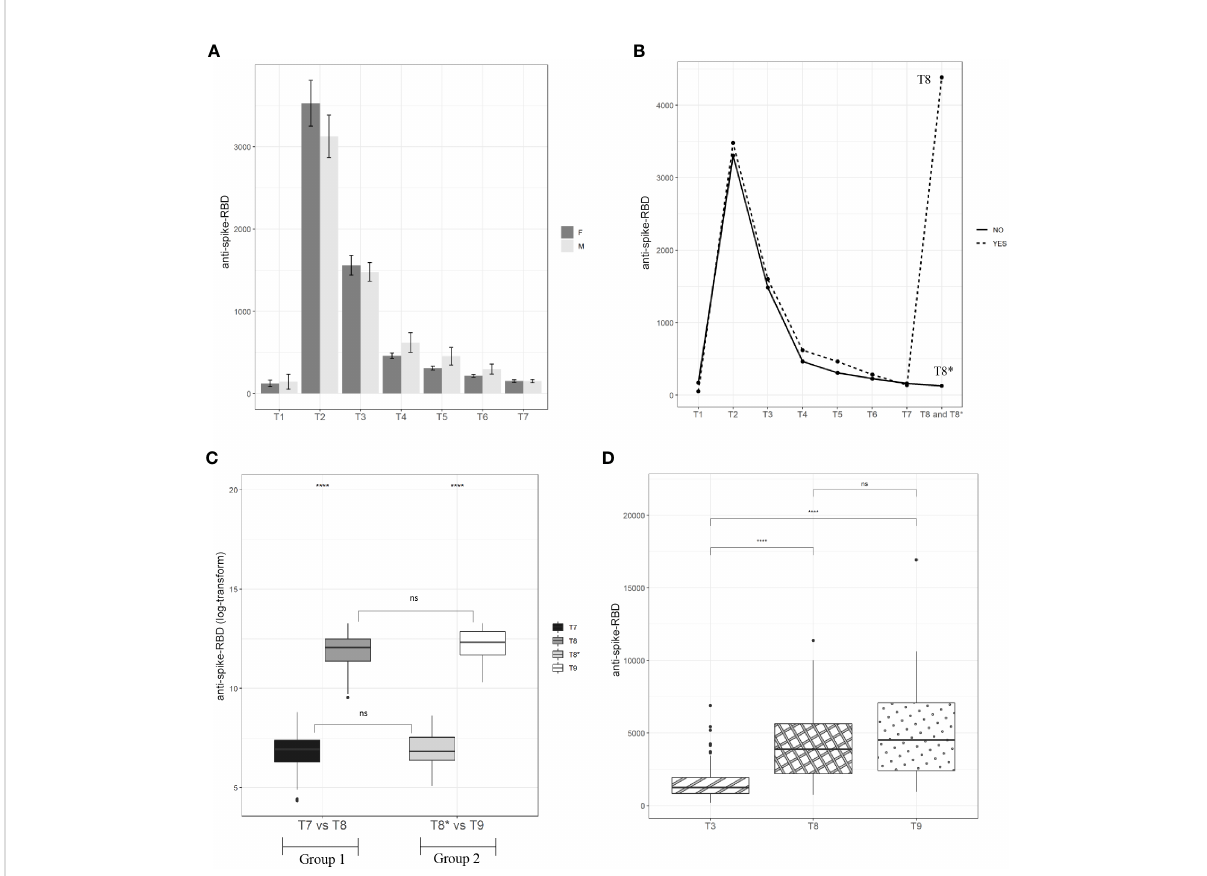
FIGURE 2 Kinetic of anti-spike-RBD antibodies. (A) A total of 94 vaccinated women and 69 men have been screened for anti-spike-RBD antibodies at the indicated time points up to 7.2 months after the second dose (T7). (B) A cohort of 163 vaccinated participants have been screened for anti- spike-RBD antibodies up to one month after the third dose (T8 for Group 1) and 9.1 months after the second dose (T8* for Group 2). (C) A total of 71 vaccinated participants (Group 1=54 and Group 2=68) have been screened for anti-spike-RBD antibodies before (T7 for Group 1 and T8* for Group 2) and after the third dose (T8 for Group 1 and T9 for Group 2). (D) Anti-spike-RBD antibodies mean value one month after the second dose (T3), one month after the third dose (T8, Group I) and one month after the third dose (T9, Group 2). Statistical signi fi cance was indicated by the star symbols (i.e., ns: p > 0.05, *p ≤ 0.05, ****p ≤